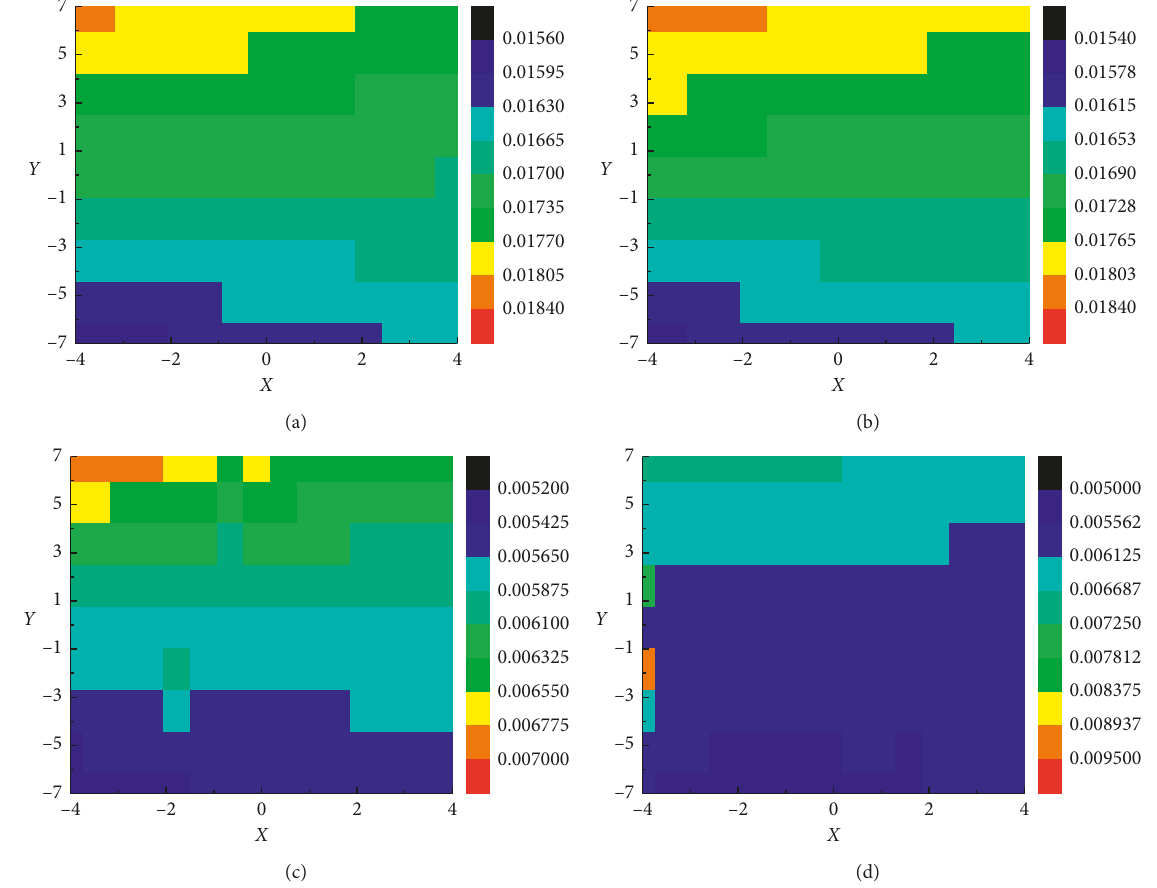
Figure 8: System response under bidirectional ground motion when primary structure is unidirectionally eccentric. (a) Displacement 1 . 6m). (b) Displacement variance of the X direction of primary structure variance of the X direction of primary structure ( X R (cid:29) ( X R 2 . 7m). (c) Displacement variance of the X direction of secondary structure ( X R 1 . 6m). (d) Displacement variance of the X (cid:29) (cid:29) 2 . direction of secondary structure ( X R (cid:29)